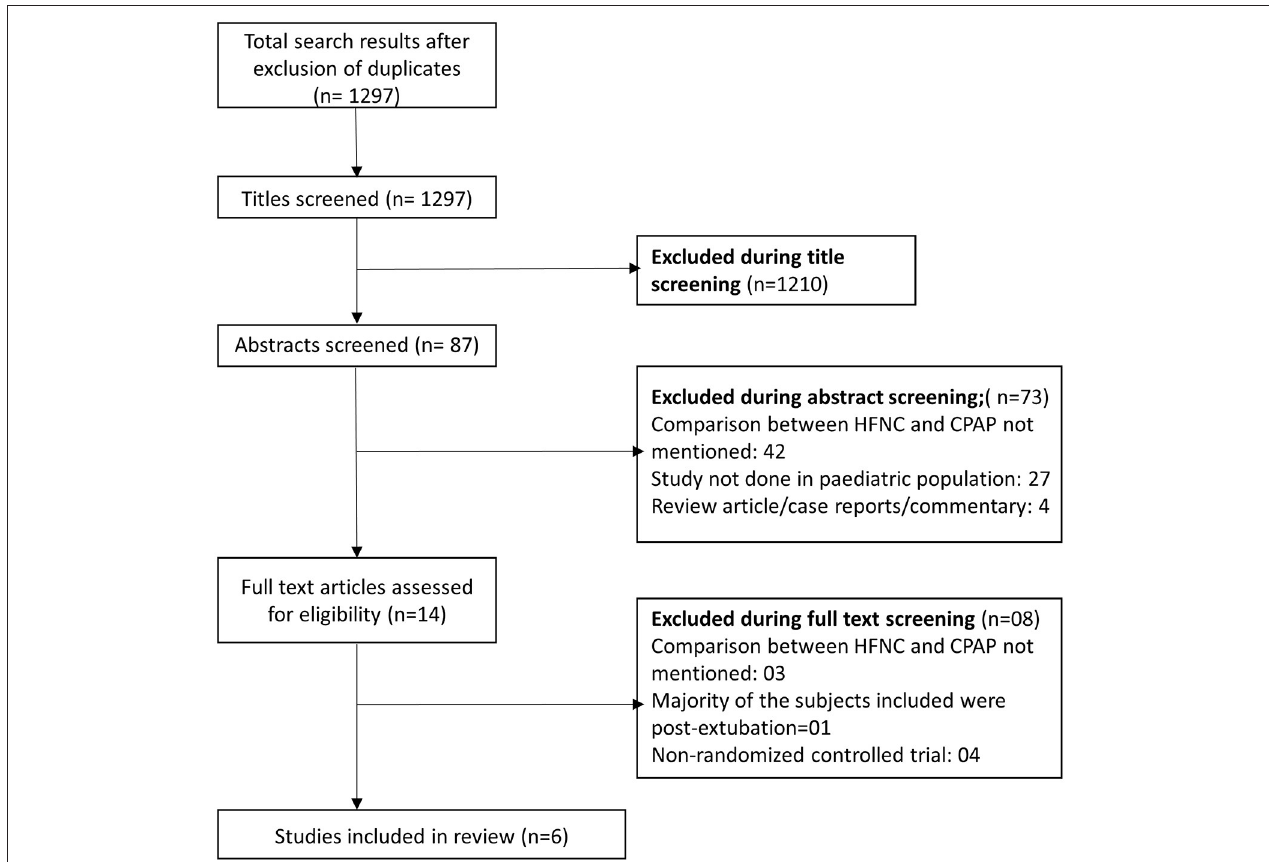
FIGURE 1 | Selection process of the studies included in the